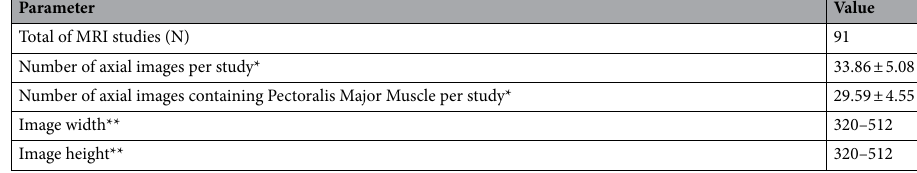
Table 1. Imaging characteristics of training dataset. *Data are mean ± standard deviation. ** Data are minimum and maximum pixel measurements. **Data are minimum and maximum pixel measurements.